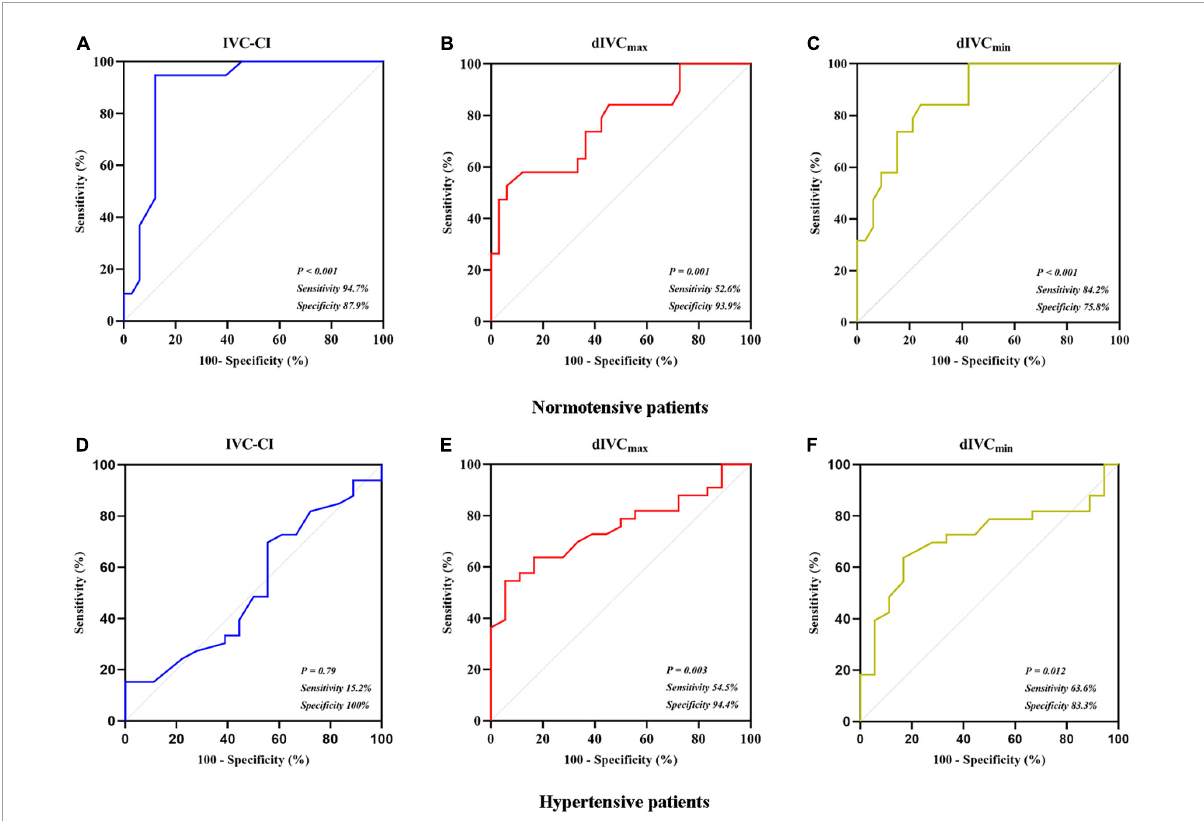
FIGURE3 Receiver operating characteristic curves. (A) IVC-CI in predicting PIH in normotensive patients; (B) dIVC max in predicting PIH in normotensive patients; (C) dIVC min in predicting PIH in normotensive patients; (D) IVC-CI in predicting PIH in hypertensive patients; (E) dIVC max in predicting PIH in hypertensive patients; and (F) dIVC min in predicting PIH in hypertensive patients.